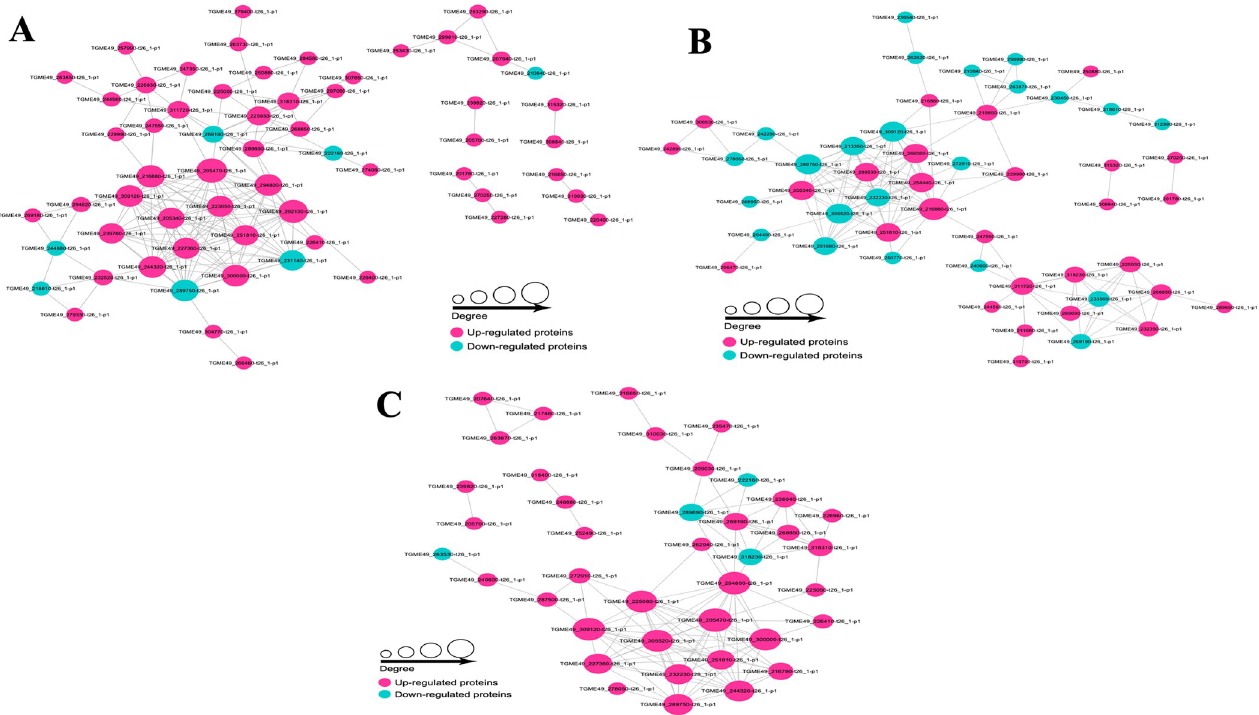
Fig 9. Protein-protein interaction (PPI) networks of the differential malonylation proteins. Cytoscape software and String database were used to construct the PPI networks of the differentially malonylated proteins in (A) RH vs. PRU, (B) RH vs. VEG, and (C) VEG vs. PRU. Nodes represent differentially expressed proteins. Size of the node represents number of the differential proteins and their interacting proteins. The larger the node, the more proteins it interacts with, indicating that the protein is more important in the network. Cyan and purple colors represent low and high expression of the corresponding proteins.